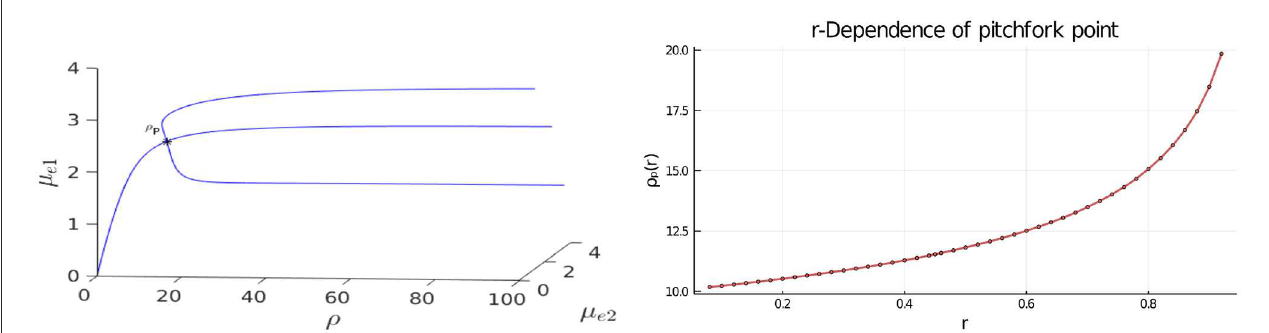
FIGURE3 Left: 3-D Bifurcation diagram, computed from Equation (4.4), showing symmetric and asymmetric steady-states of a two-cell ring pattern with ring radius r 0.5 and GM kinetics (Equation 4.3). Asymmetric steady-states emerge at the supercritical pitchfork bifurcation point ρ = symmetric branch. Right: The pitchfork bifurcation value of ρ increases rapidly as the ring radius r , and consequently the distance between the cells, increases. The dots are the values computed from Equation (4.6), while the curve is the interpolation by the plotting function in Bezanson et al. [53]. Parameters: D u